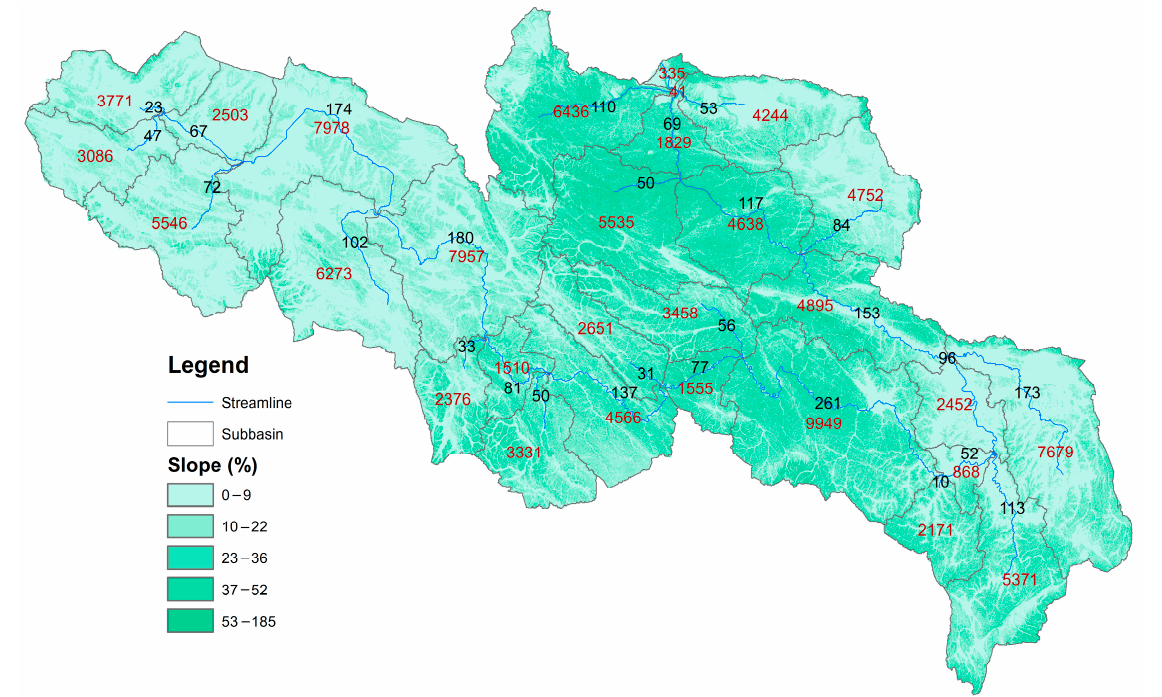
Figure 3. Some physical characteristics obtained by watershed delineation in the SYER: sub-basin area (km 2 , red values), sub-basin stream length (km, black values), and slope.